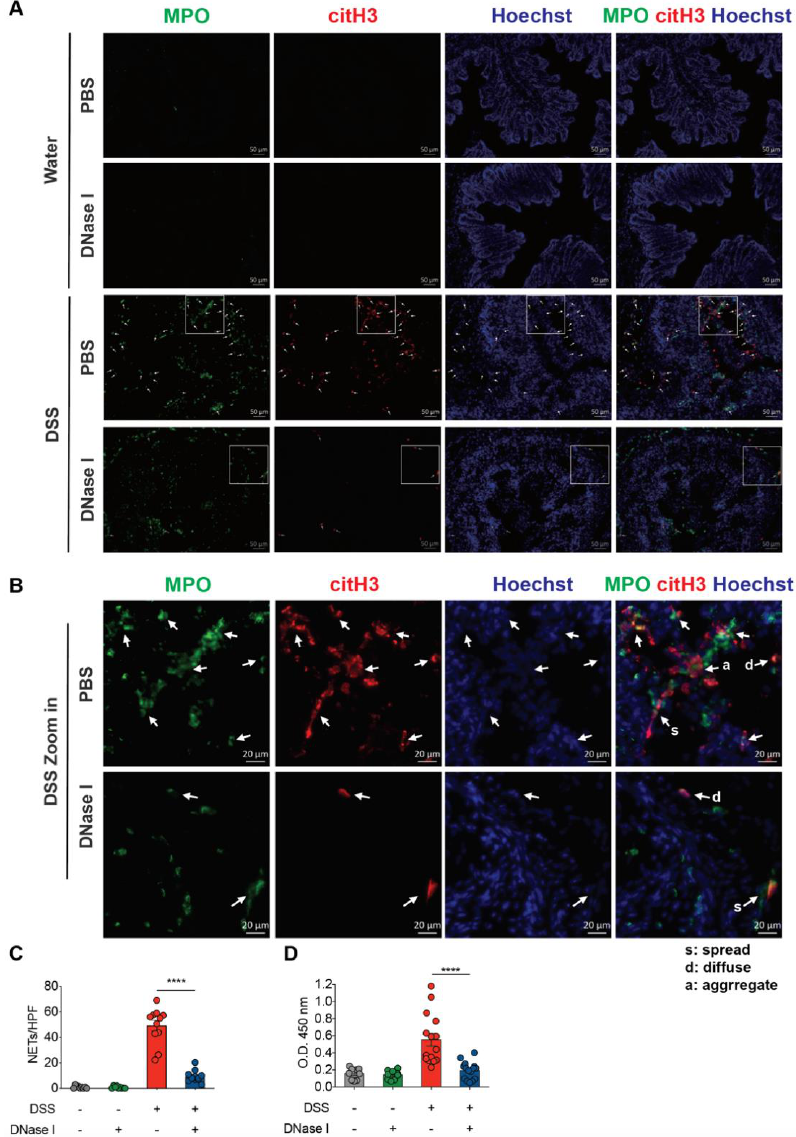
Figure 3. DNase I treatment significantly degrades NET structure in the colon of mice fed DSS. ( A ) Representative NET release (white arrows) in the colon of PBS control or DNase I-treated mice 8 d after the consumption of clean water or 2.5% DSS, assessed by the immunofluorescence microscopy of myeloperoxidase (MPO; green), citrullinated histone H3 (citH3; red), and Hoechst 33342-stained DNA (blue). ( B ) Enlargement of the area outlined in ( A ). White arrows indicate NETs. s: NETs in spread form, d: NETs in diffuse form, a: aggregate NET. ( C ) NET formation counts per 200X high- power field (HPF) in each group. ( A – C ) The results are pooled data from two separate experiments. n = 9 mice in water control groups and n = 12 mice in DSS-treated groups, at least 3 images/mouse. ( D ) NET release, measured in colon homogenates of PBS- or DNase I-administered wild-type C57BL/6 mice 8 d after the consumption of clean water or 2.5% DSS, by using MPO-DNA complex ELISA. The results are pooled data from three separate experiments. n = 9 mice per control groups and n = 15 mice per DSS groups. The data represent the mean ± SEM. Statistical analyses were performed using one- way ANOVA with Turkey’s multiple comparison. **** p < 0.0001. Scale bars, 50 µm in ( A ). 20 µm in ( B ).